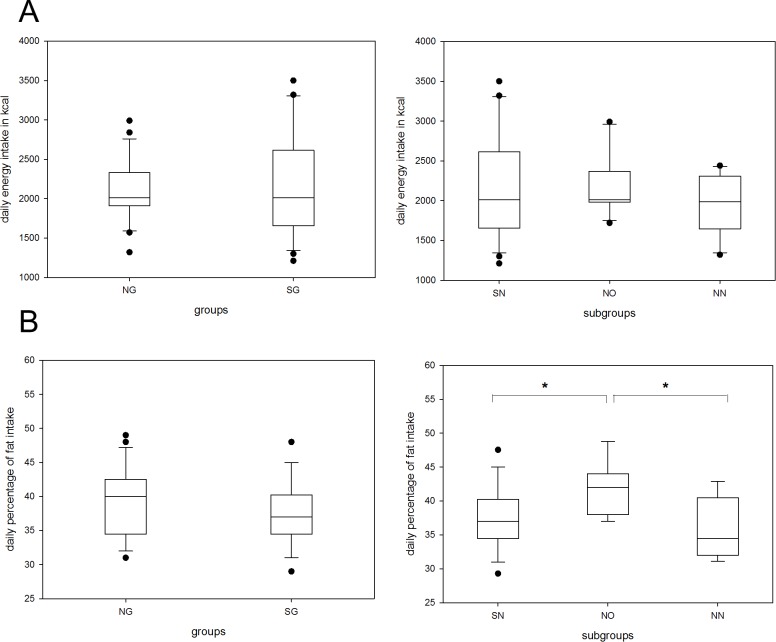
Daily energy (A) and fat intake (B) by groups and subgroups. Energy intake is calculated in kcal (A), fat intake (B) as illustrated in percent. The boxes cover the first quartile on the bottom and the third quartile on the top. Whiskers reach from the minimum to the maximum value excluding outliers (illustrated by dots). Shift-working group and shift-working nursing-staff subgroup cover identical cohorts. NG, non-shift-working group; SG, shift-working group; SN, shift-working nursing-staff subgroup; NO, non-shift-working office-staff subgroup; NN, non-shift-working nursing-staff subgroup *p<0.05.